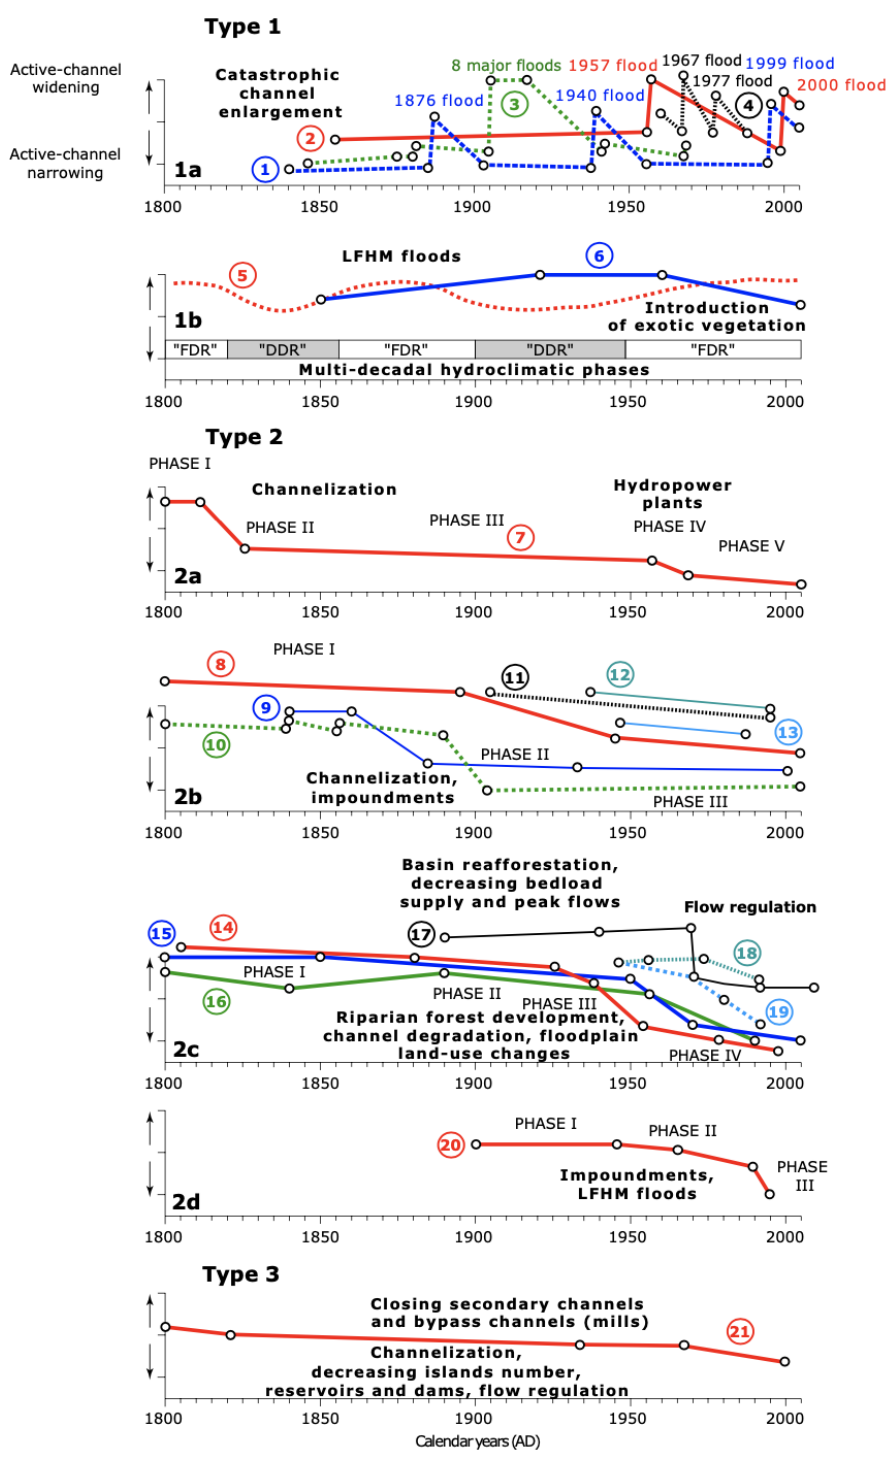
Figure 1. Typology of the recent evolution of rivers until the 2000s, just before their possible restora- tion. FDR = flood-dominated regime; DDR = drought-dominated regime; LFHM = low frequency, high magnitude. 1 (cid:13) : Argent Double River, Mediterranean France [1,2]; 2 (cid:13) : Guil River [3] and Ubaye River, Southern French Alps [4]; 3 (cid:13) : Gila River, Arizona, USA [5]; 4 (cid:13) : Barron River, North Queens- land, Australia [6]; 5 (cid:13) : Australian, NSW coastal rivers [7]; 6 (cid:13) : Lower Bega River, New South Wales, Australia [8]; 7 (cid:13) : Danube River, Austrian Machland region [9]; 8 (cid:13) : Durance River, Southern French Alps [10]; 9 (cid:13) : Swiss Rh ô ne River [11]; 10 (cid:13) : French Rh ô ne River [12,13]; 11 (cid:13) : Dore River, Massif Central, France [14]; 12 (cid:13) : French Alpine rivers [15]; 13 (cid:13) : Loire and Allier rivers, France [16]; 14 (cid:13) : French